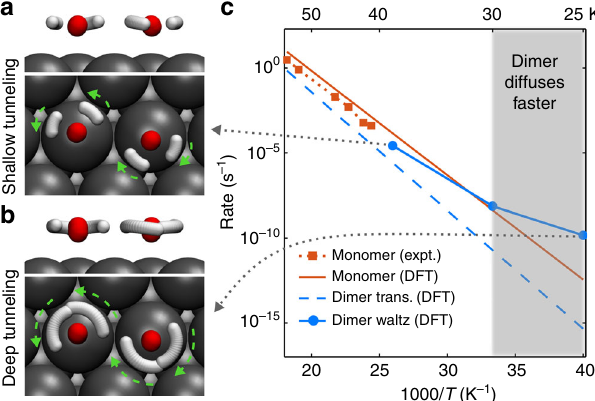
Fig. 4 Tunnelling in water dimer DA exchange step. a Side and top views of the H 2 O instanton trajectory at 38.5 K with 32 beads. b Side and top views of the H 2 O instanton trajectory at 25 K with 64 beads. c Diffusion rates versus temperature for the water monomer and dimer diffusion processes. Experimental rates from ref. 11 are shown for comparison. The shaded area marks the temperature regime where the dimer diffusion becomes faster than the monomer Table 2 T c and ZPE corrections for water monomer and dimer diffusion on metal (111) surfaces. DA exchange step Dimer trans. Mono. trans.